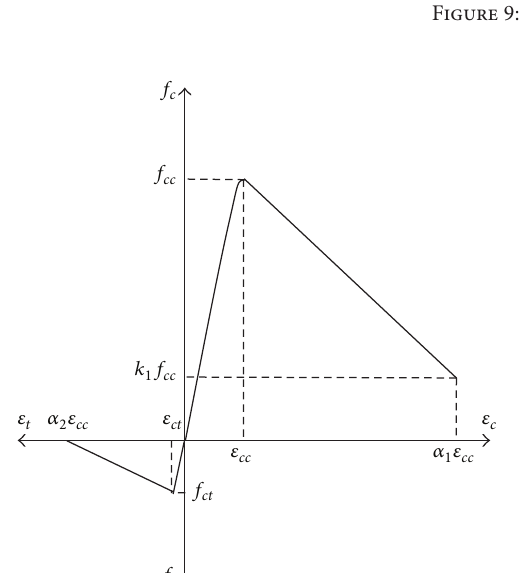
Figure 10: Typical material properties for brittle rock materials.